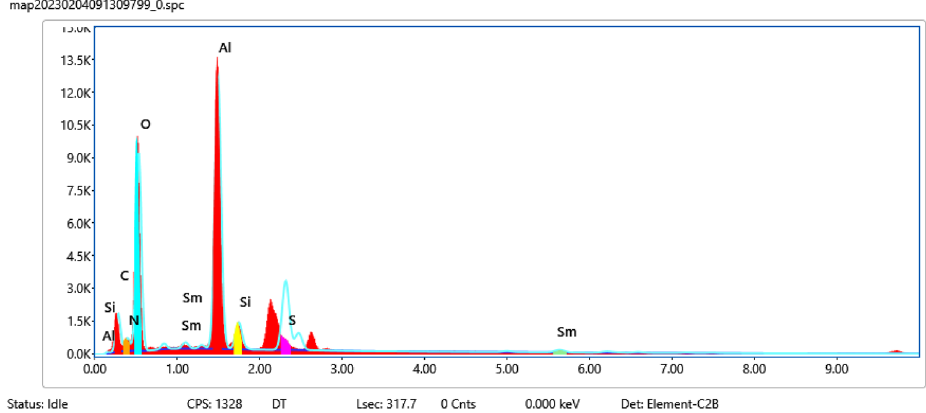
Figure 17. EDS diagram of recovered Sm-bis(PYT)@boehmite.